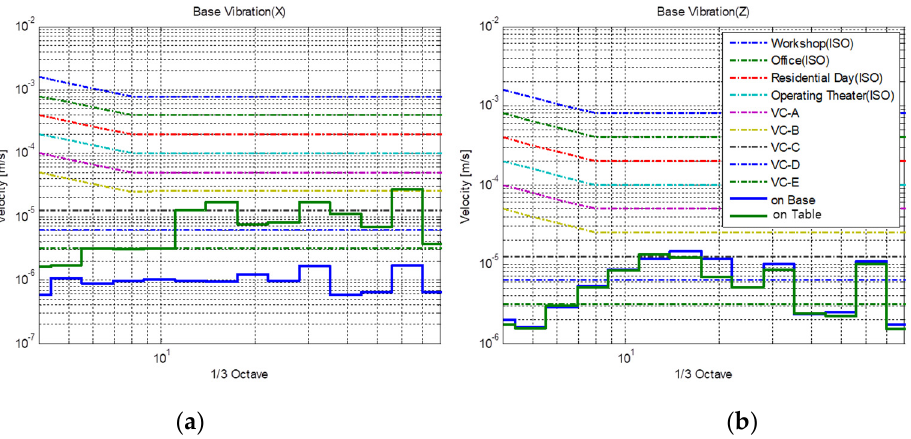
Figure 3. Vibration characteristics of the floor and table versus the frequency in the ( a ) horizontal ( x - axis in Figure 1); ( b ) vertical ( z -axis in Figure 1) directions. ( x -axis in Figure 1); ( b ) vertical ( z -axis in Figure 1)